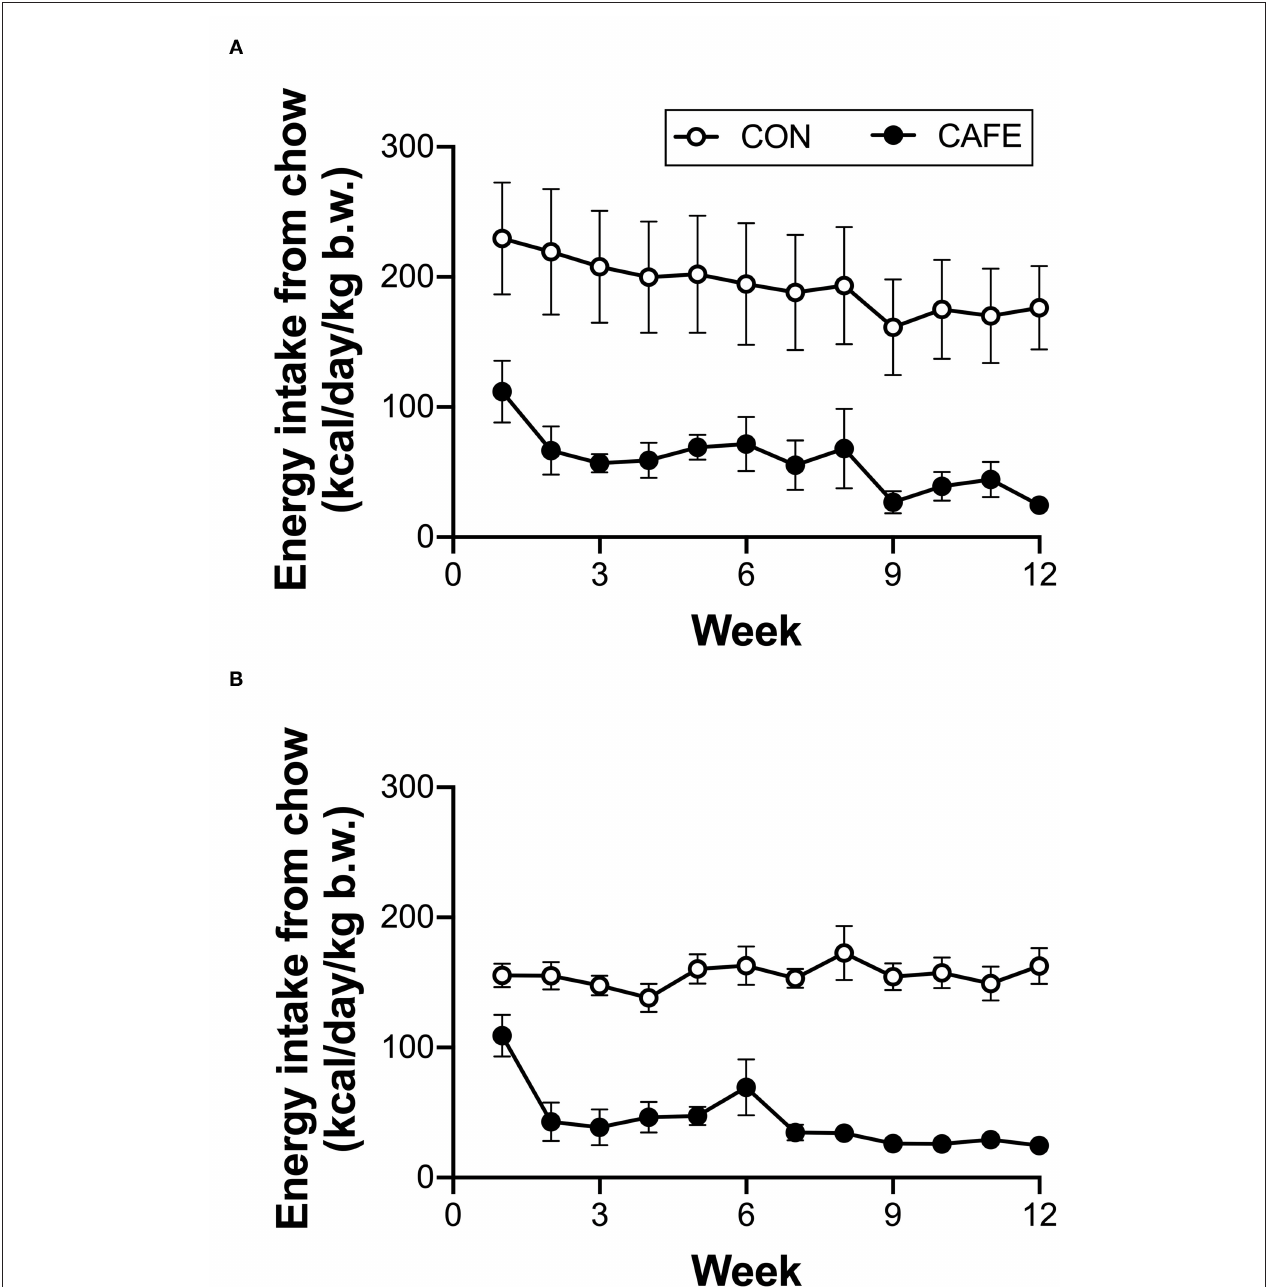
FIGURE 1 | Longitudinal impact of experimental cafeteria diet on chow consumption in young (A) and old (B) Brown Norway rats. A significant effect of the cafeteria diet on chow consumption was observed in both young ( P < 0.05) and old ( P < 0.001) animals. Values represent cage averages ± SEM. n = 4 cages/group.